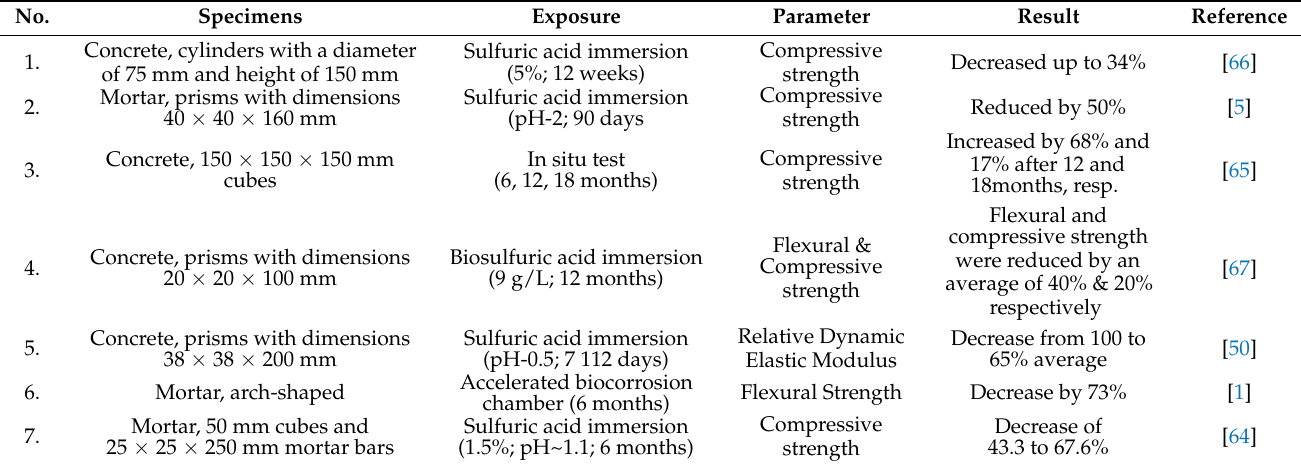
Table 2. Summary of effect of biocorrosion on strength